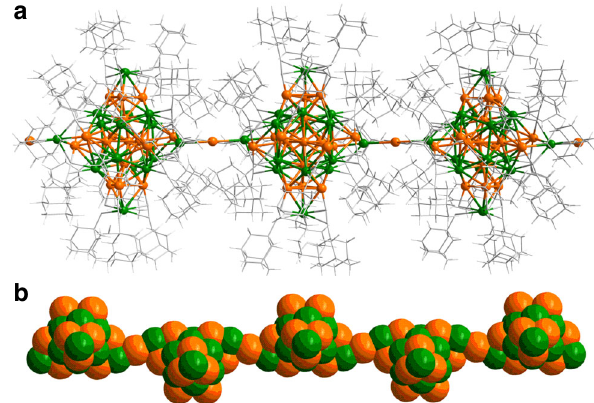
Fig. 4 Atomic structure of the cluster polymer. a Total structure viewed approximately orthogonal to the c -axis (parallel direction). b Space- fi lling view of the metal atoms (viewed from the top direction in a ). Colors: golden and green, Au/Ag; gray, C. All hydrogen atoms are omitted